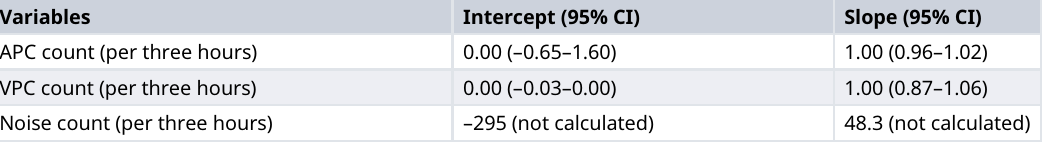
Table 3. Passing-Bablock analysis between wearable ECG and Holter